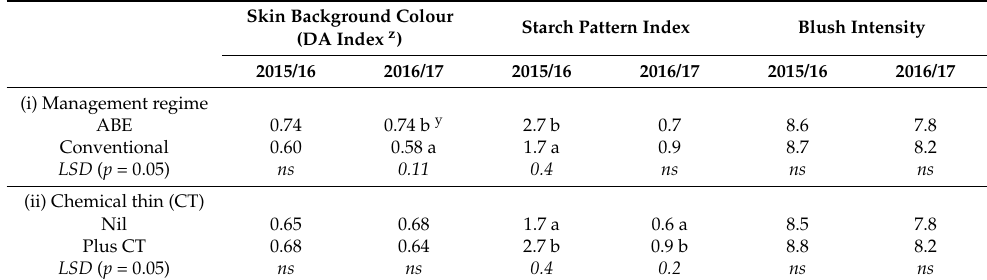
Table 8. Effect of management regime and thinning method on fruit maturity and blush intensity of ‘Alvina Gala’ (Trial 2). ABE = artificial bud extinction.